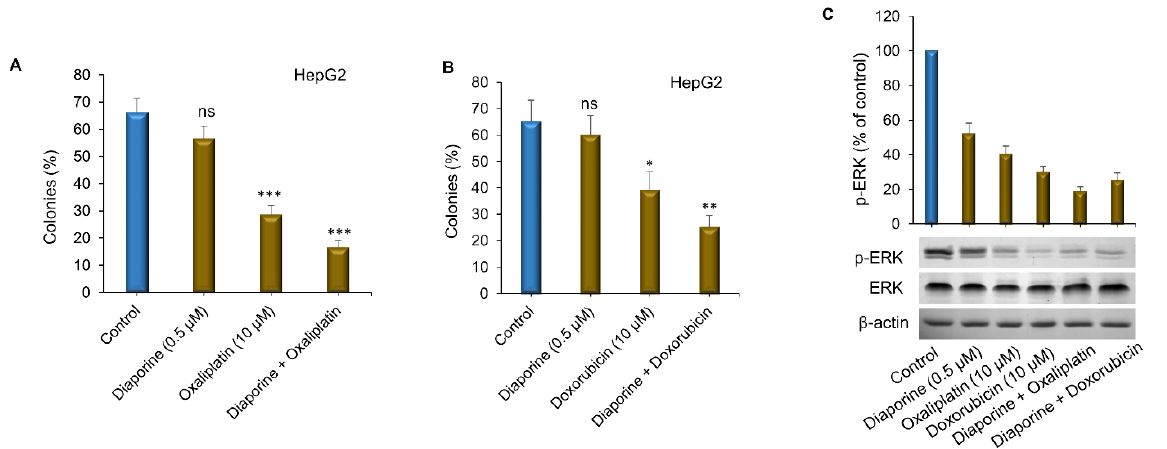
Figure 2. Diaporine augments the inhibition of HepG2 cell numbers by ( A ) oxaliplatin (1–10 μM) and ( B ) Doxorubicin (0.5–2.5 μM). Cells were treated with the indicated drugs for 48 h, and all experiments were repeated at least 3 times. The data are presented as SEM. ** p < 0.01; *** p < 0.001; ns, not significant. Diaporine has synergic cytotoxic effects with oxaliplatin ( C ) or doxorubicin ( D ) in HepG2 cells. Combination index (CI) plots (Fa-CI plot) were generated by CompuSyn software (ComboSyn Inc., Paramus, NJ, USA) according to the Chou–Talalay method. Synergy is present when CI < 1.0 Fa: inhibitory effect, CI: combination index.